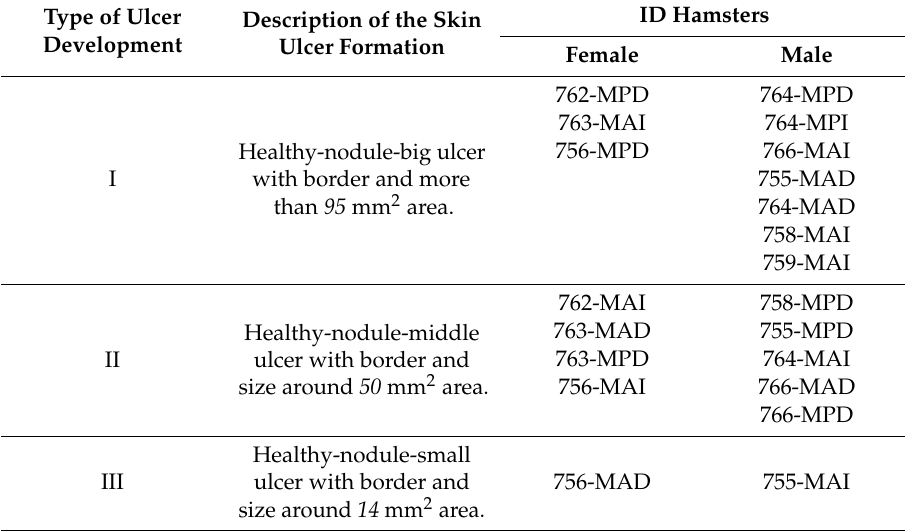
Table A1. Types of skin ulcer’s formation according to its final